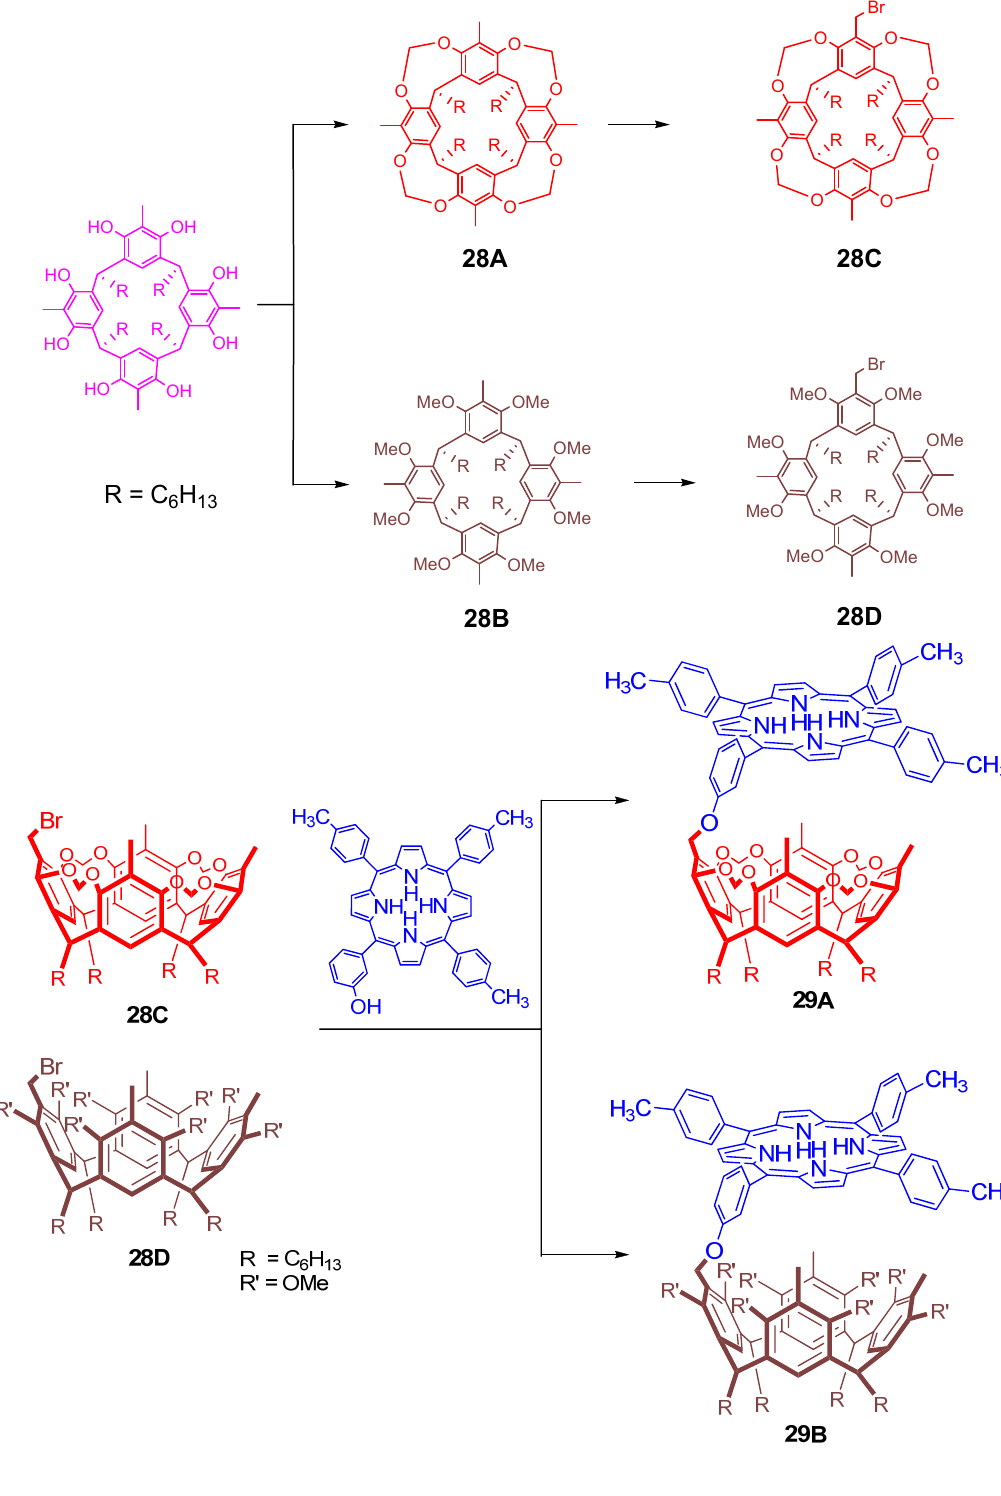
Figure 29. Synthetic pathways of resorcin[4]arene ( 28A-D ) for the preparation of porphyrin conjugated rigid resorcin[4]arene ( 29A ) and its flexible analogue ( 29B